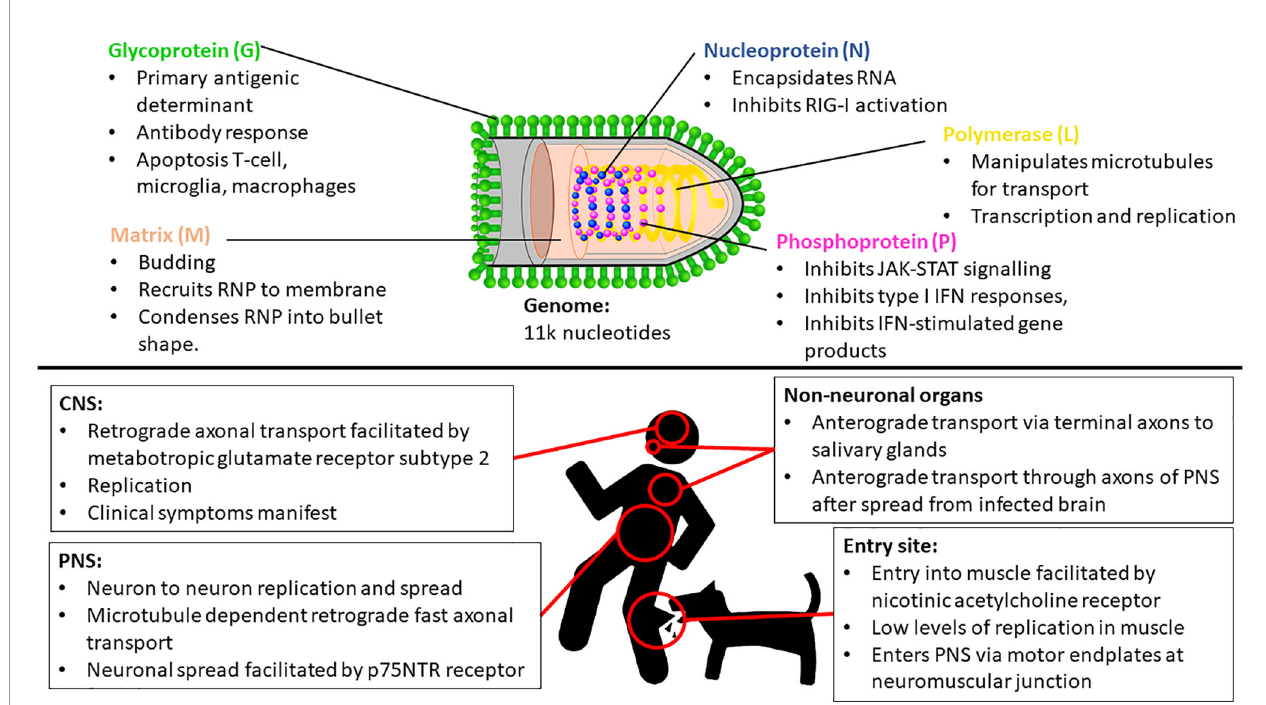
FIGURE 1 | Key insights of Rabies lyssavirus (RABV) entry, spread and proliferation, and some important functionalities of each RABV protein. IFN, Interferon; CNS, Central nervous system; PNS, Peripheral nervous system; RNP, Ribonucleoprotein